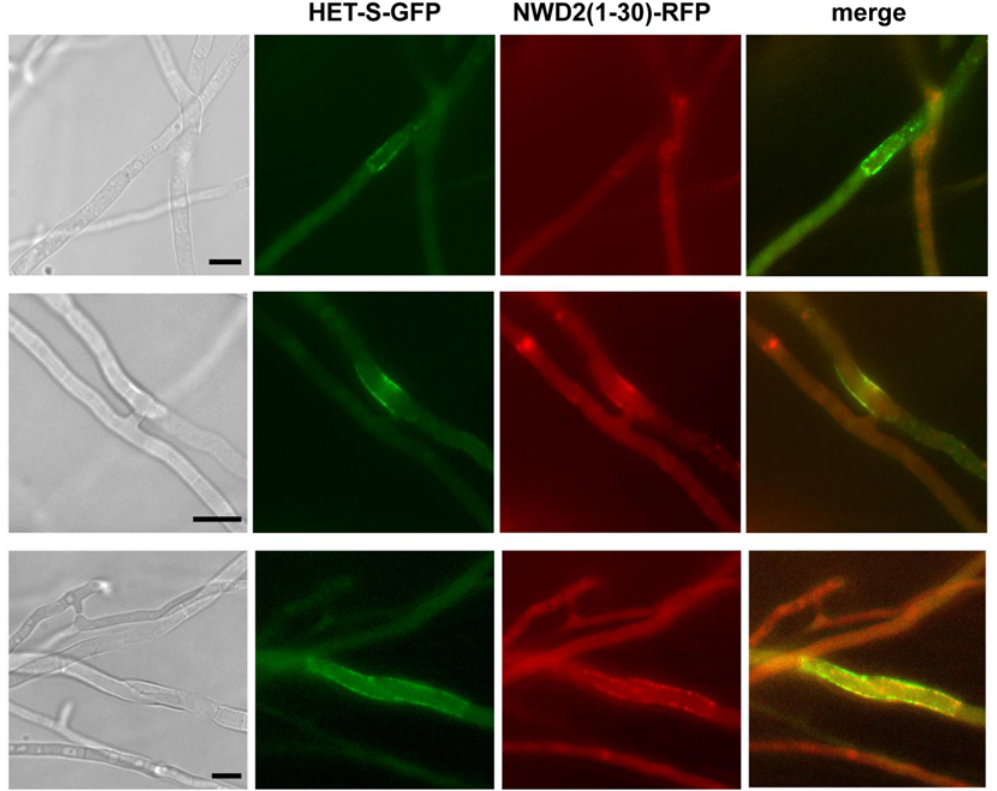
Fig 6. NWD2(1 – 30)-RFP causes re-localization of HET-S-GFP to the cell periphery. A strain expressing NWD2(1 – 30)-RFP was confronted to a strain expressing HET-S-GFP and heterokaryotic fusion cells were analyzed by fluorescence microscopy. Panels correspond from left to right to the bright field, GFP, RFP, and merged images. Note that HET-S-GFP localizes to the cell periphery and shows partial co-localization with NWD2(3 – 23)-RFP. Scale bar is 5 μ . The presented zoomed images are given in the full field from which they were extracted in S4